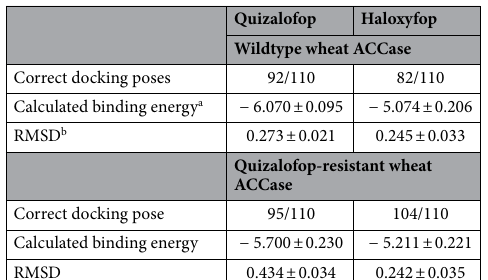
Table 4. Docking parameters of quizalofop and haloxyfop on wheat ACCase. a Calculated binding energy in kcal mol −1 . b RMSD relative to initial coordinate of quizalofop or haloxyfop based on the crystal structure of